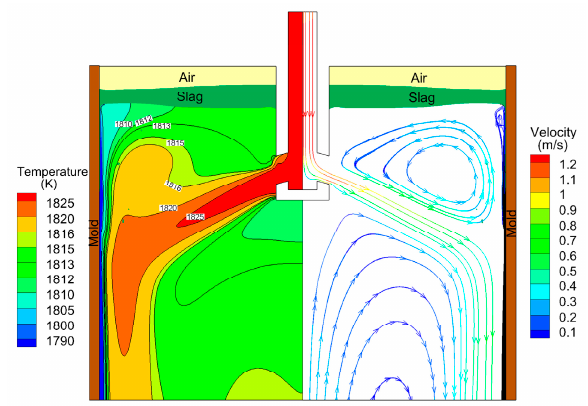
Figure 3. Flow field, temperature field, and phase distribution in the mold.